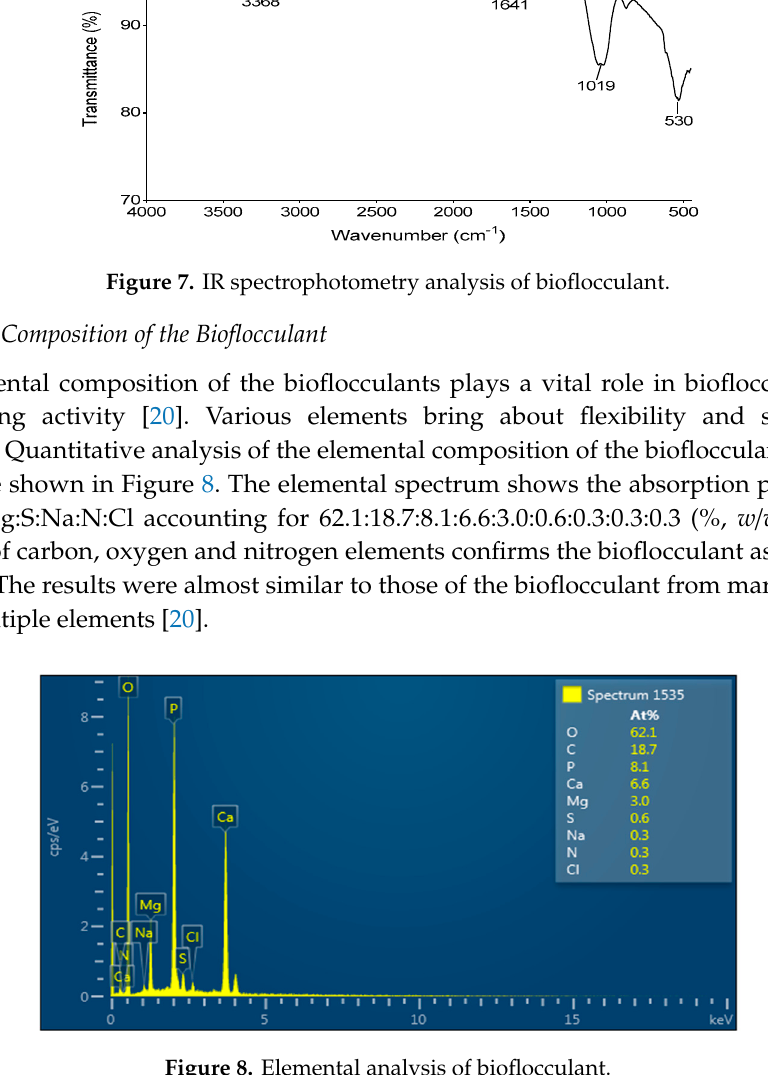
Figure 9. Thermo-gravimetric analysis of the bioflocculant. 3.16. Cytotoxic Effect of the Bioflocculant on HEK 293 Cell-line Although bioflocculants have been generally affirmed as non-toxic compounds, for biosafety reasons, they still need to be tested for their toxicity before use [60]. This is due to the fact that some may impose toxic effects [5]. In this study, the bioflocculant showed a margin of safety, as it had no significant cytotoxic effect on the tested cell line (Figure 10). HEK 293 cell-line exhibited 95% viability after being treated with the highest concentration of bioflocculant (200 µg/µL). The results affirmed the probable safe utilization of the bioflocculants in different applications. The results were in agreement with those of Sharma et al . [62], where the exopolymer produced by Acinetobacter haemolyticus showed no toxicity on sheep blood cells. The same biopolymer had no effect in an in- Temperature ( o C) 0